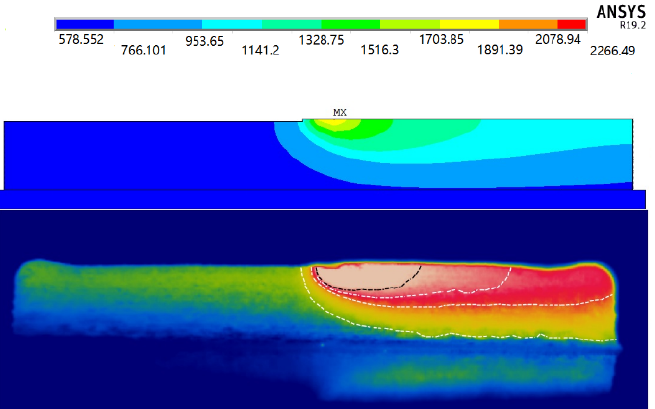
Figure 13. Temperature field distribution of thin-walled parts at a specific time: temperature distribution of thin-walled parts solved by ANSYS (top); and temperature distribution of thin-walled parts recorded by the infrared camera (bottom).